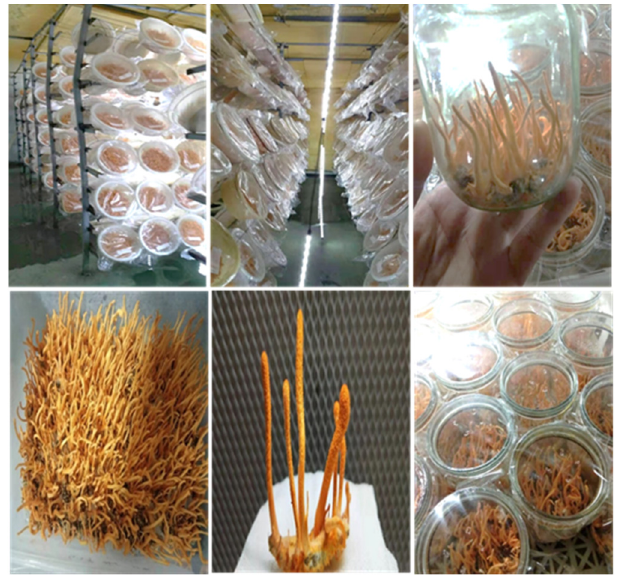
Figure 1. Cordyceps militaris fruiting body cultivation—Shanghai.